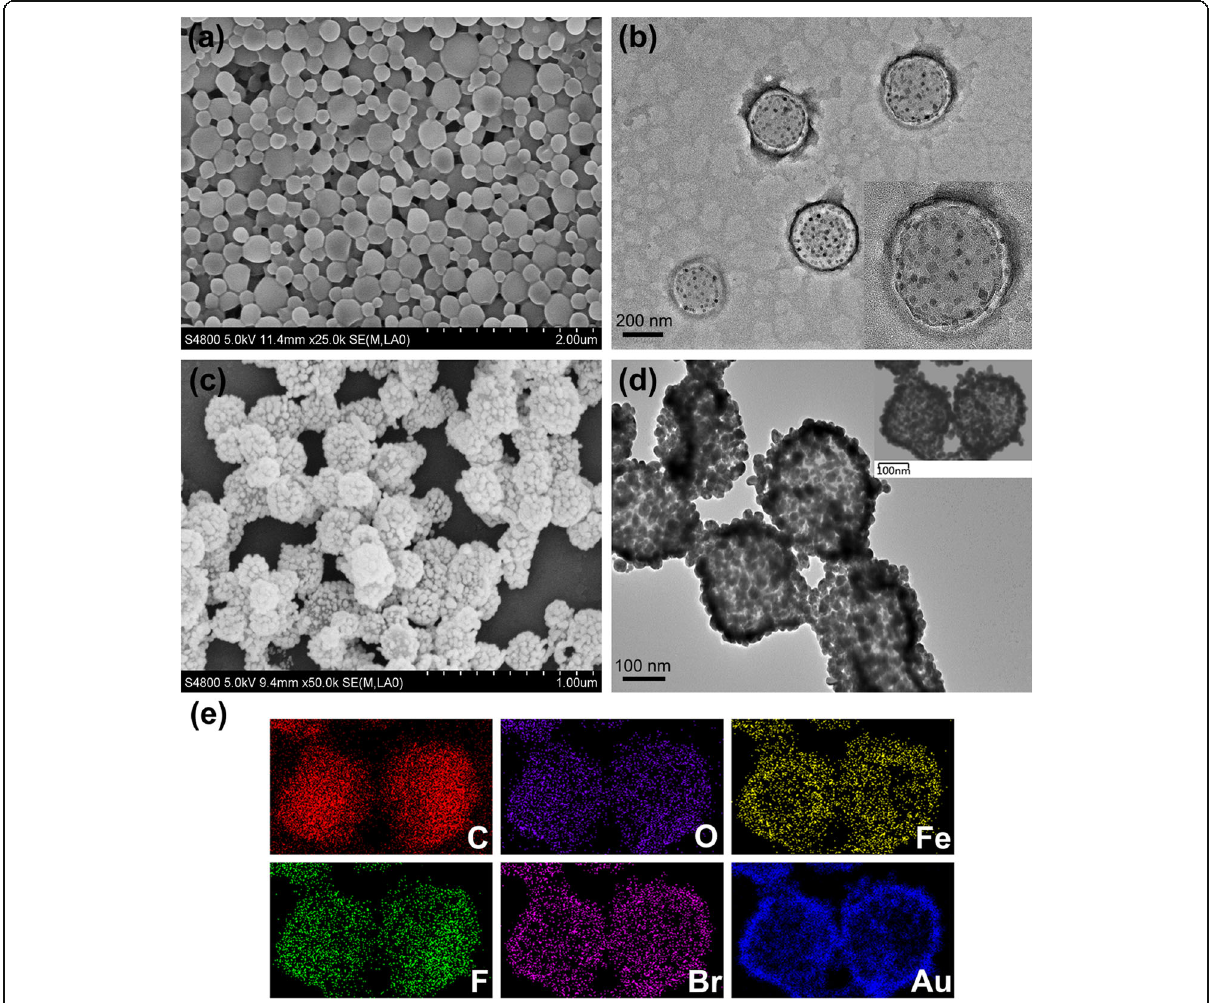
Fig. 2 Characterizations of Her2-GPH NPs. a SEM (scale = 2 μ m) and b TEM (scale = 200 nm) images of PFOB/SPIOs@PLGA NPs; c SEM (scale = 1 μ m) and d TEM (scale = 100 nm) images of Her2-GPH NPs; e EDS element mapping images show the distributions of C, O, Fe, F, Br, and